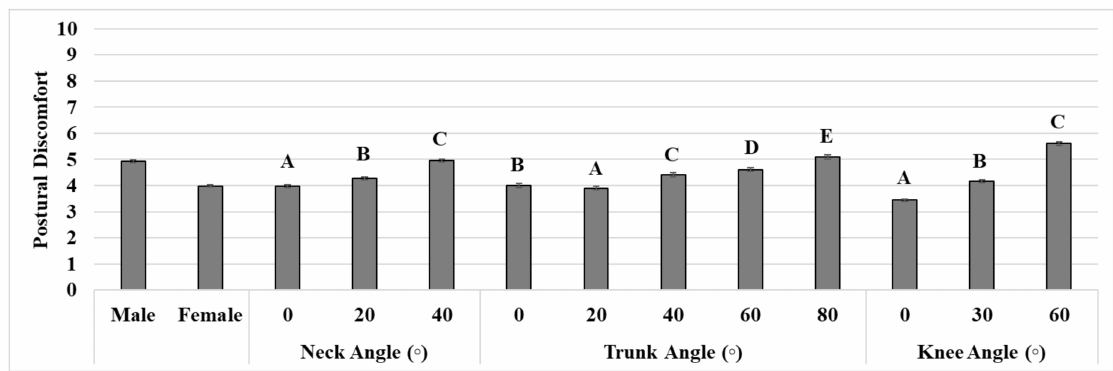
Figure 2. Means and standard errors (error bars) of postural discomfort in terms of the gender, neck, trunk, and knee flexion angles. Di ff erent letters above the bars indicate a significant di ff erence between the angles for each body segment based on a post-hoc test (Wilcoxon signed-rank